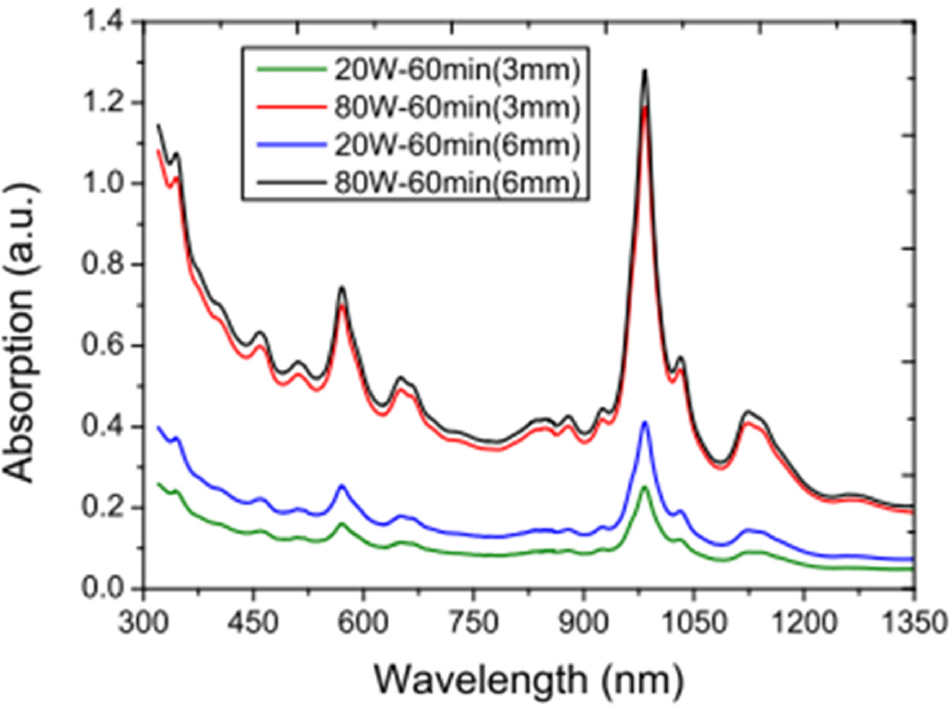
Figure 15. Comparison of the absorption spectra for the SWCNT NF dispersed using 3-mm and 6-mm sonication tips. Adapted from